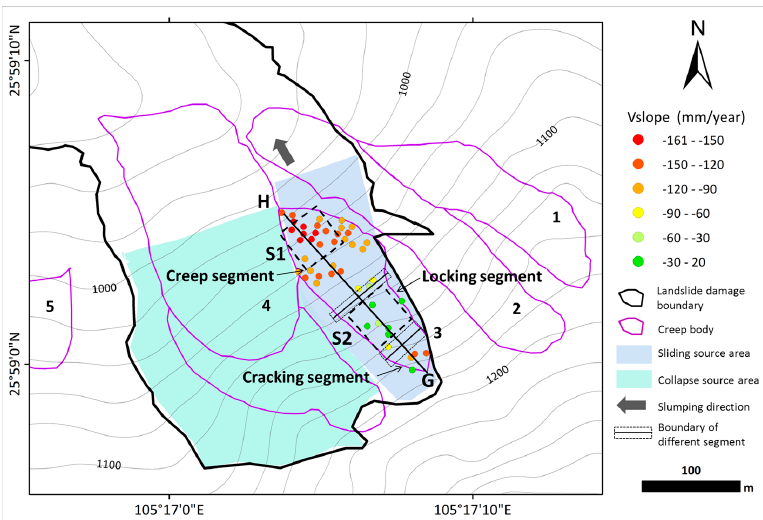
Figure 8. The deformation map along the slope direction of creep body 3, which is divided into the creep segment in the front, locking segment in the middle, and cracking segment in the rear. The solid line GH denotes a profile across the creep body 3. Two rectangles across the creep body 3 indicate the boundaries of different segments, which are perpendicular to the slide direction of the landslide. As the boundaries cannot be determined accurately, the width of the rectangle shows the uncertainty of the boundaries. The sliding and collapse source areas were mapped by the Geological Environment Monitoring Institute of the Guizhou Province through geological survey, field investigation, and aerial photogrammetry image analysis [4].